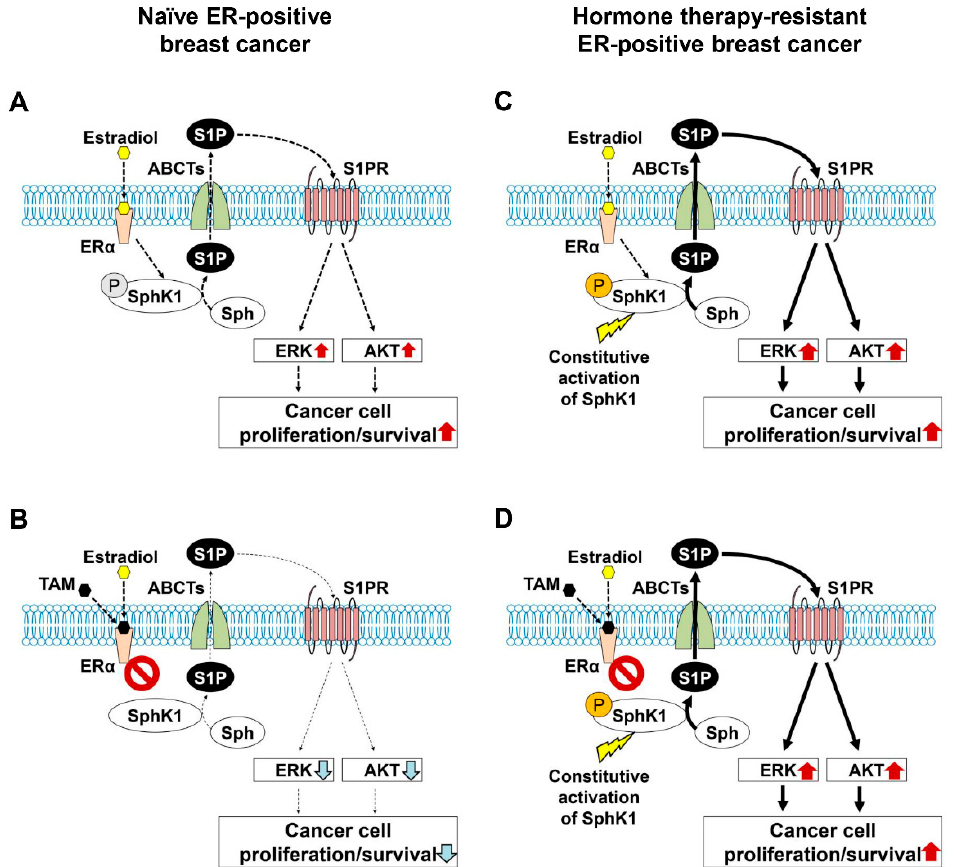
Figure 2. Scheme highlighting the importance of sphingosine-1-phosphate (S1P) signaling in breast cancer (BC) with estrogen receptor (ER)-positive status, even with hormone therapy resistance. Binding of estradiol to ER α stimulates production and release of S1P via ABC transporters (ABCTs) ABCC1 and ABCG2. Outside of the cells, S1P binds to S1P receptors to stimulate ERK and AKT, leading to activation of further downstream signaling pathways important for BC cell proliferation and survival ( A ). Tamoxifen (TAM), an ER α antagonist, blocks production and release of S1P, so that BC progression may be suppressed ( B ). In contrast, production and release of S1P by constitutive activation of SphK1 may result in an enhancement of cell proliferation and survival without estradiol ( C ). Hormone therapies such as TAM are unlikely to be effective in a situation of high S1P with constitutive activation of SphK1 in ER-positive BC ( D ).